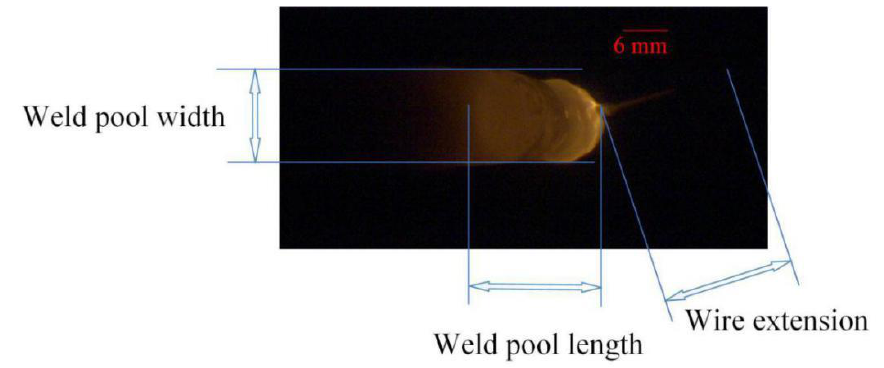
Figure 4. Schematic diagram of visual features of molten pool.